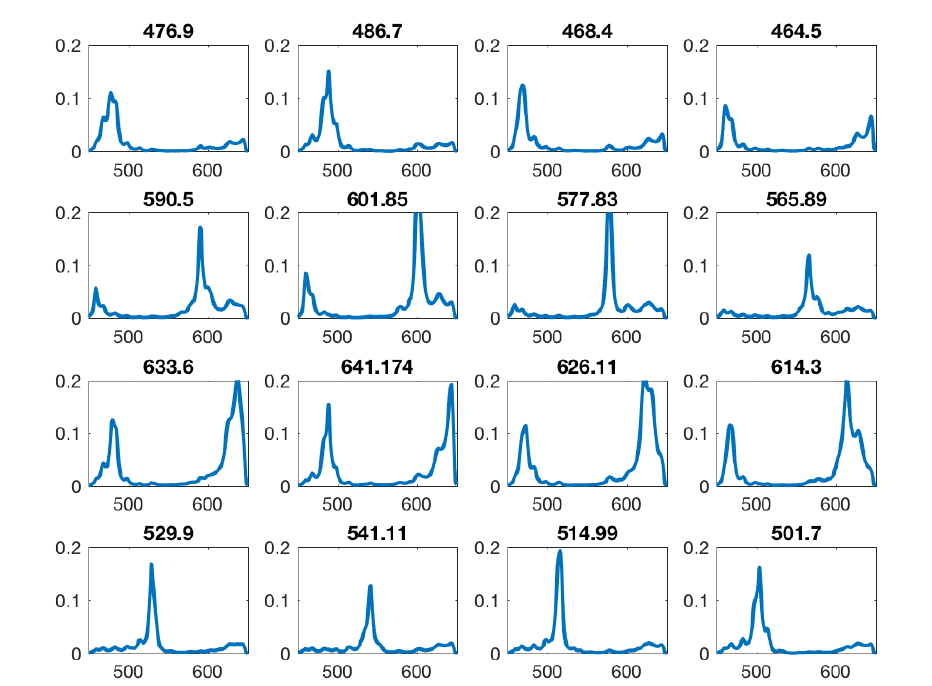
Figure 5. All filter sensitivity multiplied by the bandpass. Many filters show a second order peak inside the sensitive area. Intended peak wavelength shown above of each filter sensitivity curve.